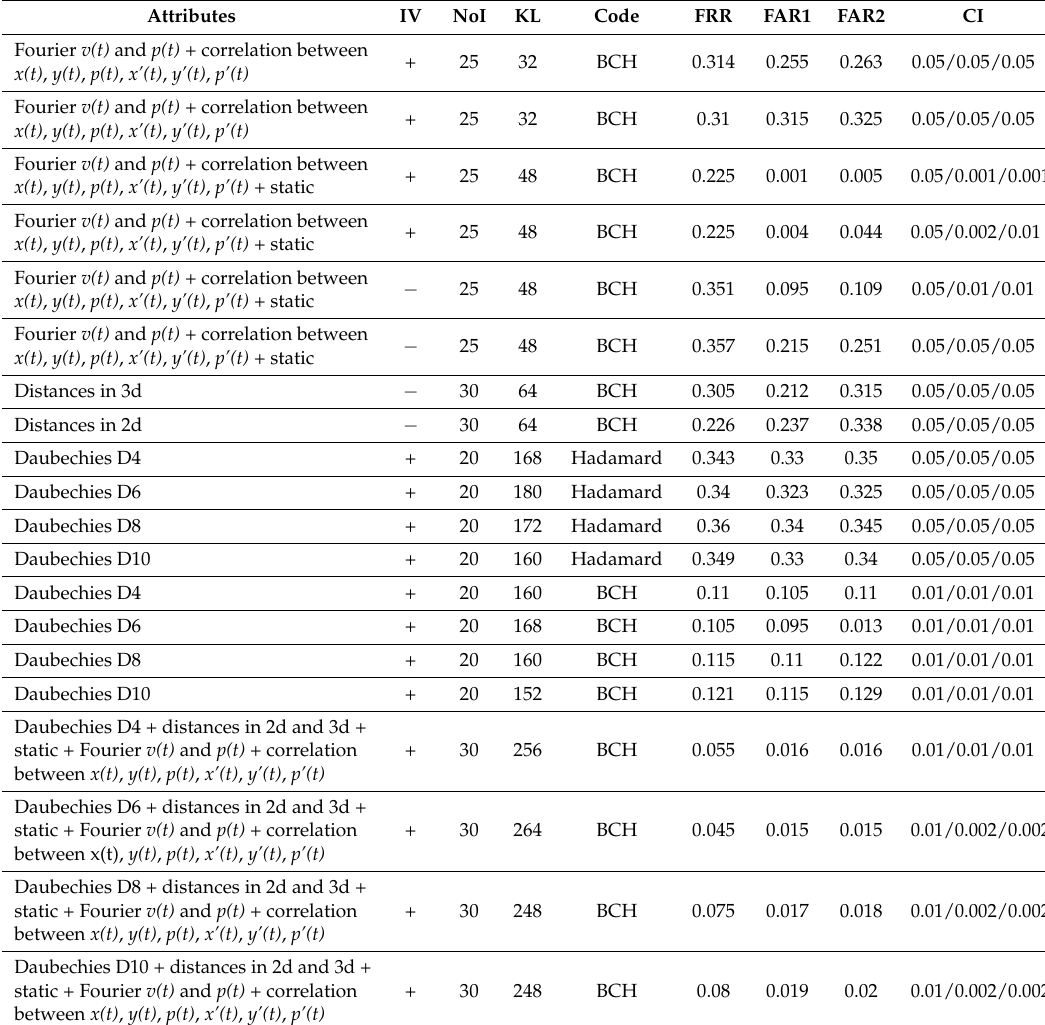
Table 2. The main results of generating key sequences using handwritten passwords and signatures. IV —the procedure of estimation of informative value (stability) of features; NoI —number of signature instances when forming the open string; KL —the length of generated key in bits; Code